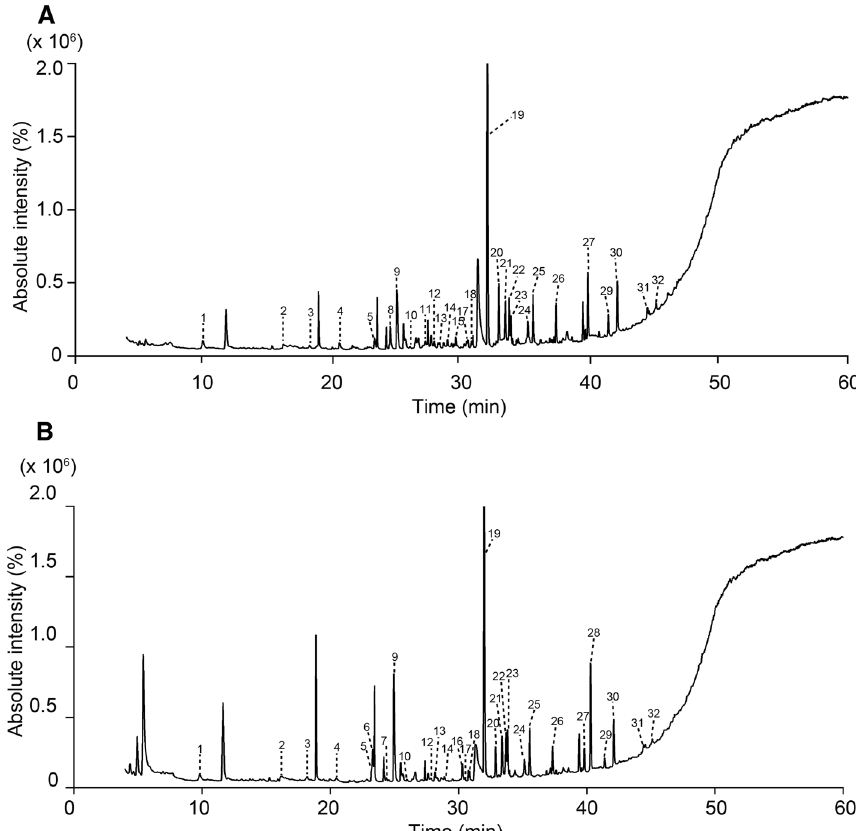
Fig. 2 Typical gas chromatography–mass spectrometry chromatogram of total ion current of volatile organic compounds in the urine of a healthy control a and a patient with major depressive disorder b Total ion currents (TICs) were obtained from the analysis of the sam- ples (200 µL) using headspace solid-phase microextraction (divinylbenzene/carboxen/polydimethylsiloxane, 50/30 µM, 2 cm) and gas chro- matography-mass spectrometry ( GC–MS) equipped with a ULBON HR-20 M capillary column (30 m, internal diameter 0.32 mm, thickness 0.5 µM). The extraction temperature was 45 °C, and the extraction time was 60 min. Desorption was performed at 240 °C for 3 min. The injection was pulsed splitless (closed, 3 min). The temperature program consisted of an initial temperature of 40 °C for 10 min, followed by an increase of 5 °C /min to 240 °C with the final temperature held for 10 min. The numbers indicate the metabolites whose similarity indices were > 85. 1: 4-heptanone; 2: 2-acetyl-2 H -tetrazole; 3: 2-propanone, 1-hydroxy; 4: allyl isothiocyanate; 5: acetic acid; 6: 1-butene,